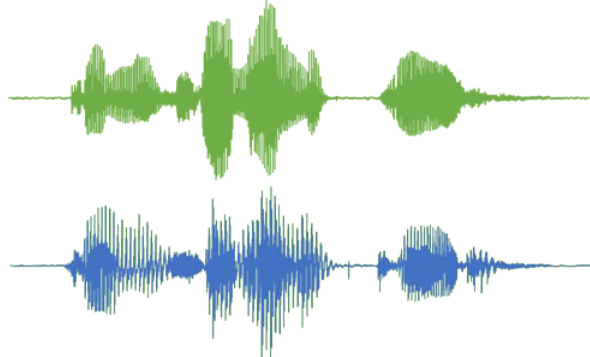
Figure 5 | The two speech signals after synchronization where each distinct sound is located at the same time instant (horizontal axis) in both utterances.